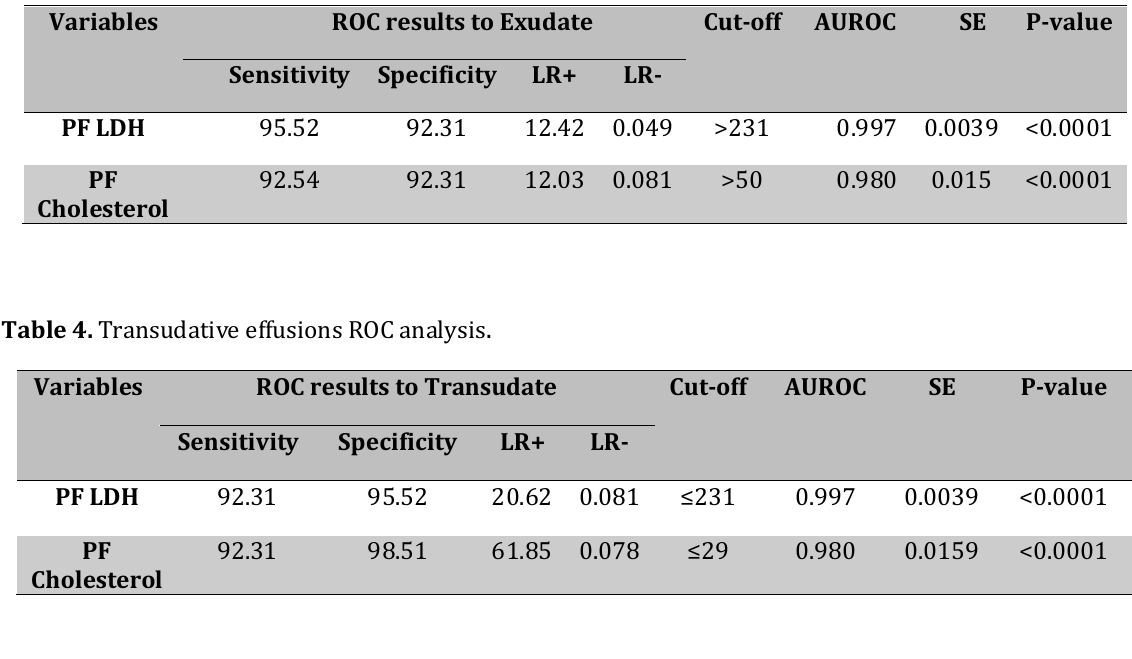
Table 3. Exudative effusions ROC analysis.